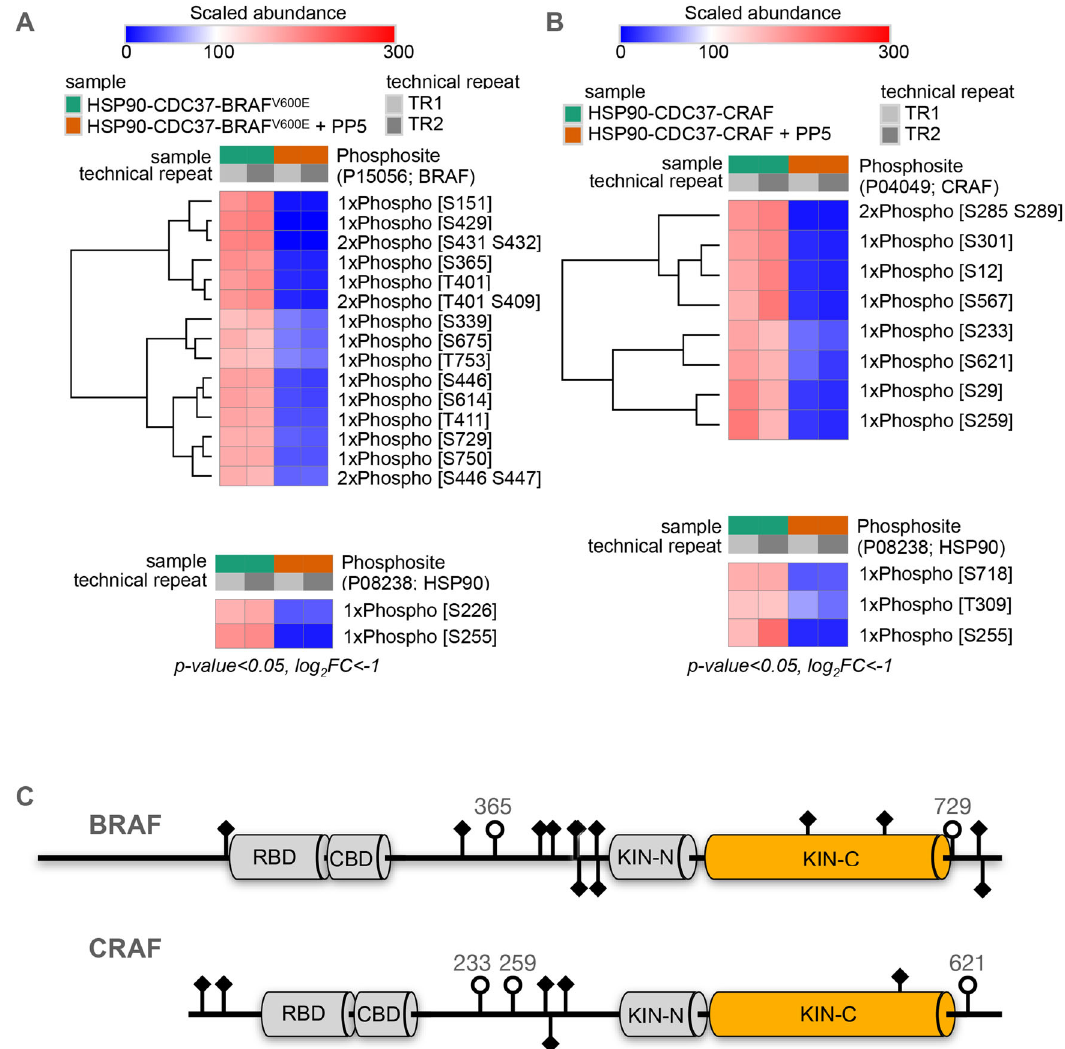
Fig. 4 | PP5 is a comprehensive remover of client phosphorylations. A Comparison of phosphopeptide abundances from mass spectrometry analysis of BRAF V600E inthecontextofacomplexwithHSP90-CDC37,withorwithoutincubation with PP5, each with two technical repeats utilising different labelling. Peptides are clusteredonscaledabundance.Statisticalanalysiswasperformedwithatwo-sided t - test and multiple hypothesis testing corrections by permutation-based FDR. Sig- ni fi cant hits were fi ltered for p-value<0.05, log2fold-change< − 1 and had an FDR< 0.1. B As A. but for a CRAF – HSP90 – CDC37 complex. C Schematic of phosphoryla- tion sites identi fi ed in HSP90 – CDC37-associated BRAF V600E and HSP90 – CDC37-